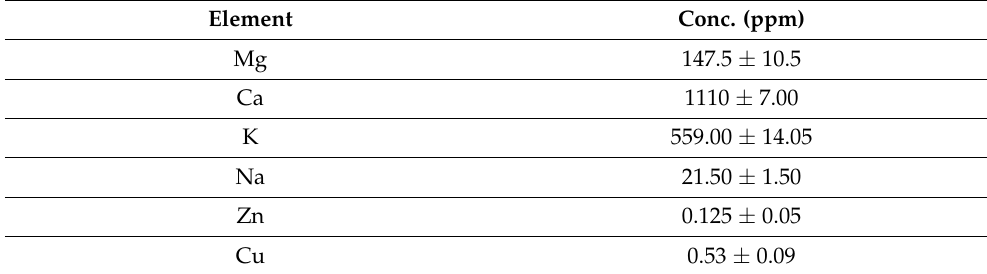
Table 2. Mineral composition of Moringa leaves.